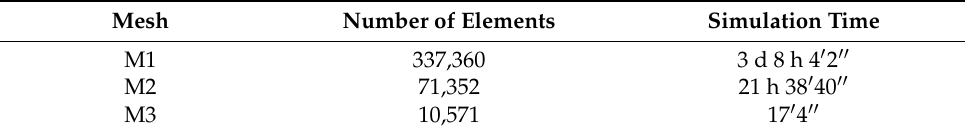
Table 4. Mesh data obtained in the convergence index analysis.